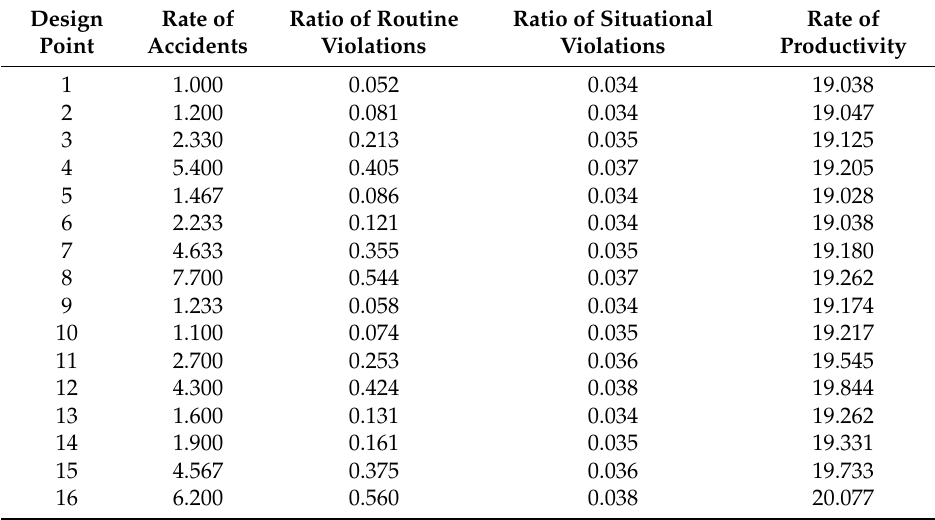
Table 6. Average response variables for the “modest” onsite condition.